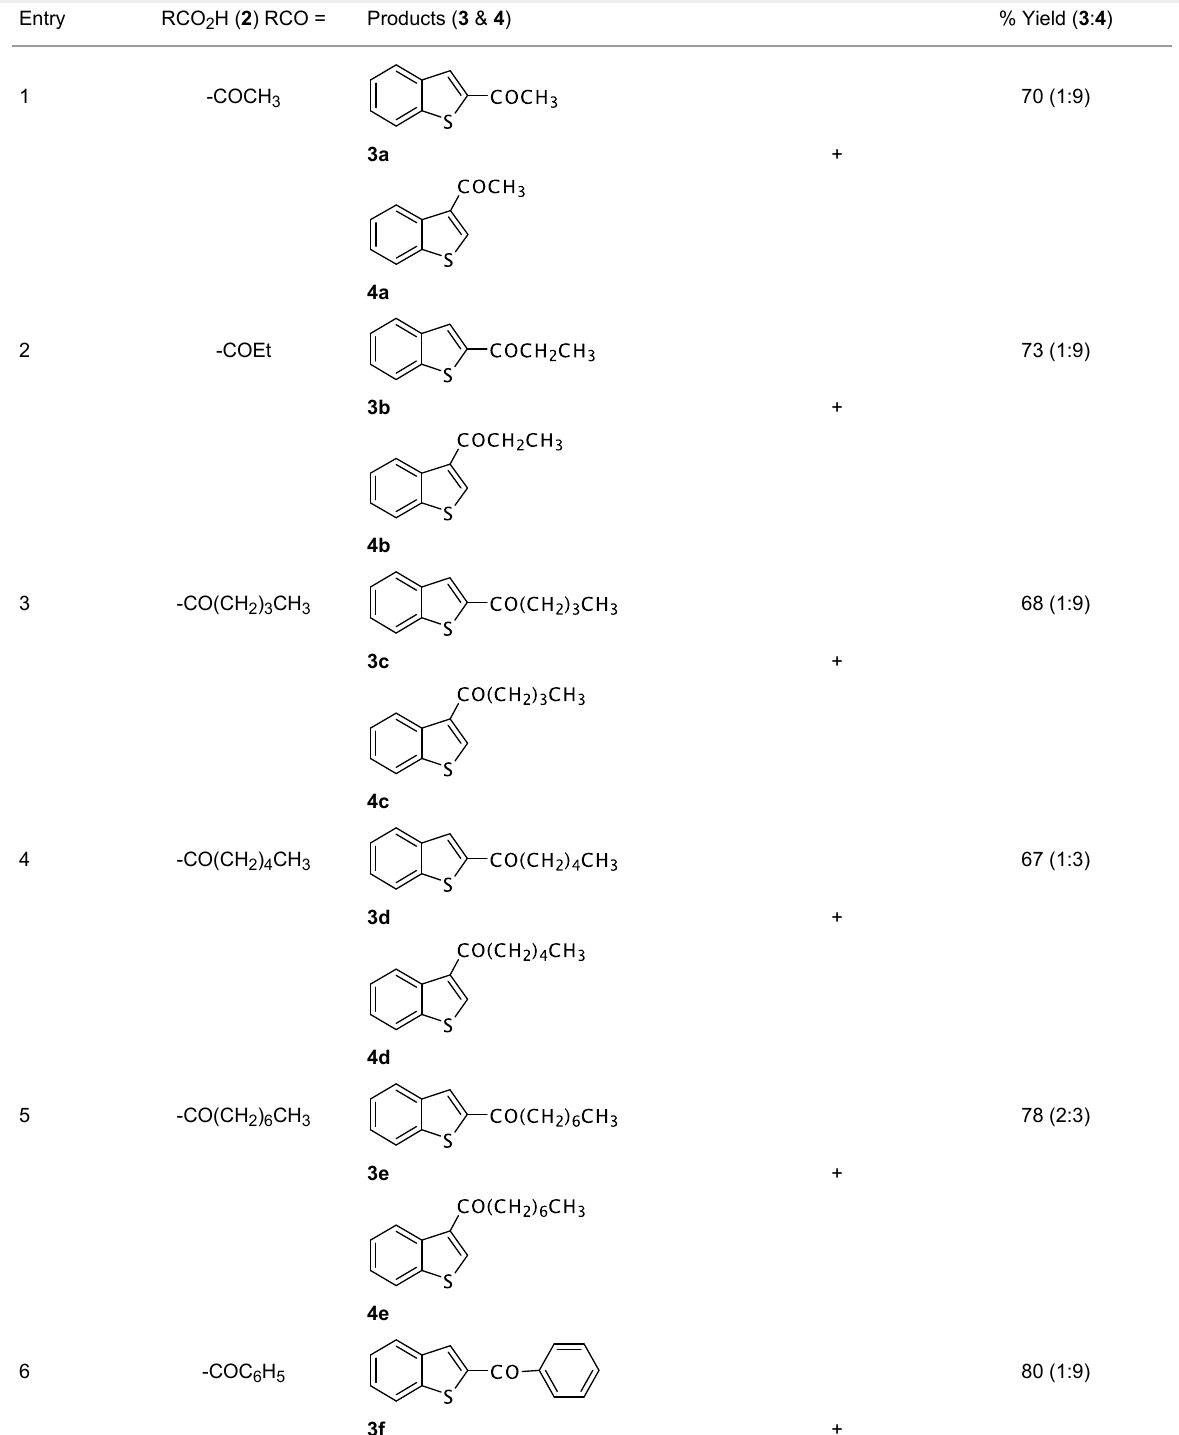
Table 1: Synthesis of acyl substituted benzothiophenes ( 3 & 4 ) via acylation of benzothiophene ( 1 ) with alkyl/aryl acids